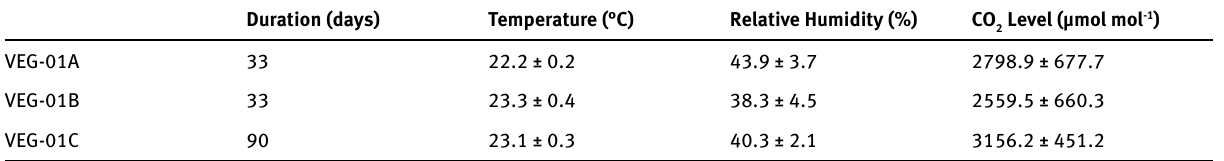
Table 1. Durations and ISS environmental data for VEG-01A, B, and C. Data points are averages ± standard deviations for all days of experi- mentation from initiation until harvest. VEG-01A data were downlinked from sensors in the US Laboratory Module, while for VEG-01B and C, data were downlinked from Columbus module sensors. VEG-0-1A and C data are averages of data collected every minute, while VEG-01B data points are averages of data at 5 minute intervals Duration